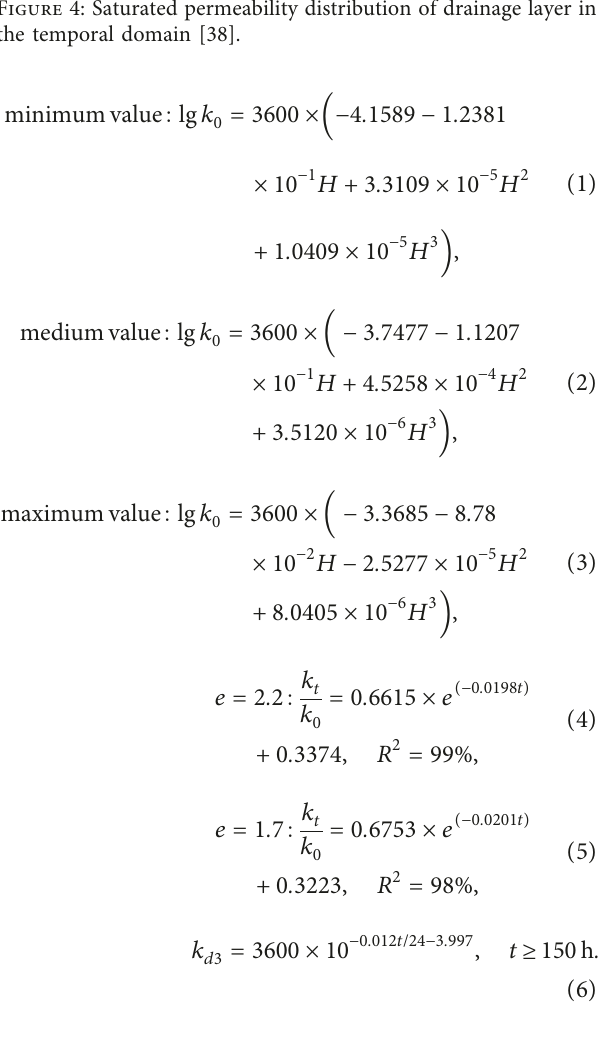
Figure 5. The slope ratio is 1 : 3, and the slope height is